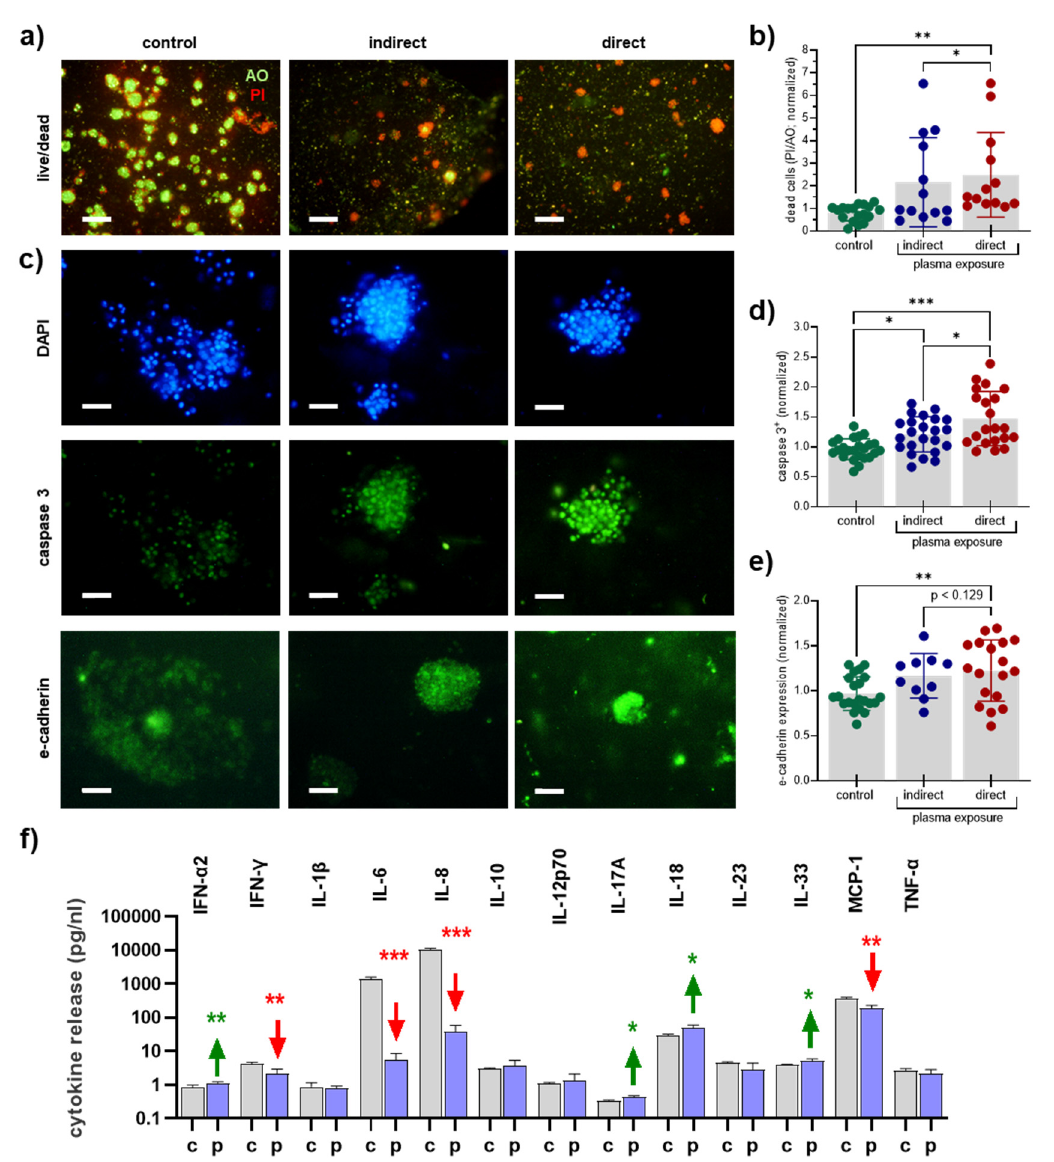
Figure 4. Microscopy and supernatant analysis. ( a ) representative fluorescence microscopy images of human patient-derived breast cancer tissue 24h after the second plasma treatment followed by staining with acridine orange (AO) and propidium iodide (PI); ( b ) quantification of dead cells; ( c ) representative fluorescence microscopy images of thin-sectioned patient-derived breast cancer tissues and staining with DAPI and anti-activated caspase 3 or anti E-cadherin antibodies; ( d – e ) quantification of caspase 3 positive cells ( d ) and E-cadherin expression ( e ) in untreated and direct or indirect plasma-treated human patient-derived breast cancer tissues; data ( b , d , e ) are mean and standard deviation of at least ten patients per group; ( f ) multiplex chemokine/cytokine analysis of supernatants from untreated and direct plasma-treated samples showing absolute levels in pg/mL of 13 targets. Statistical analysis was performed using one-way ANOVA ( b , d , e ) or t -tests ( f ), all with (*) being p < 0.05, (**) being p <0.01, and (***) being p < 0.001. Scale bars are 200 µ m (AO/PI and E-cadherin) and 100 µ m (DAPI and caspase 3). c = control, p =